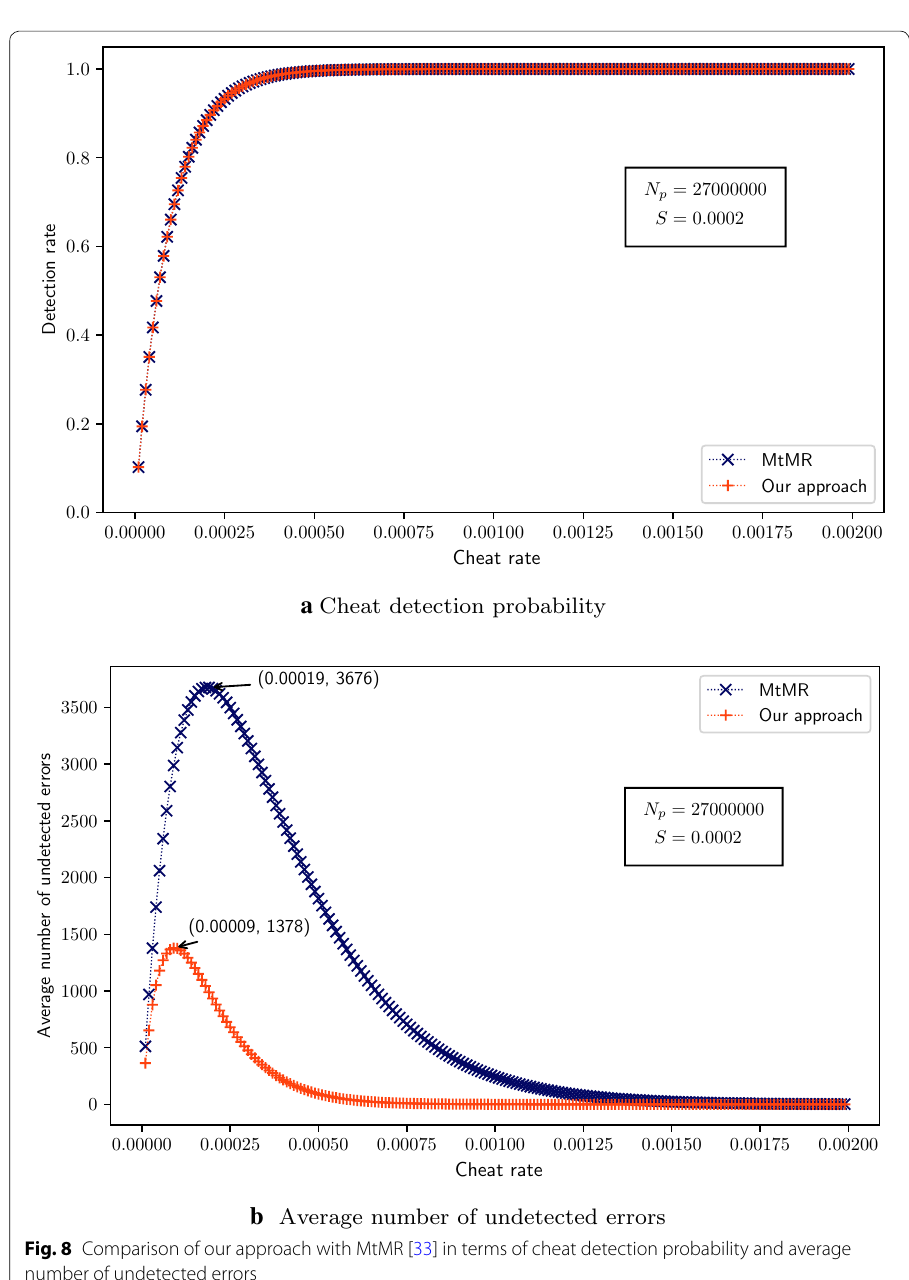
Fig. 8 Comparison of our approach with MtMR [33] in terms of cheat detection probability and average number of undetected errors